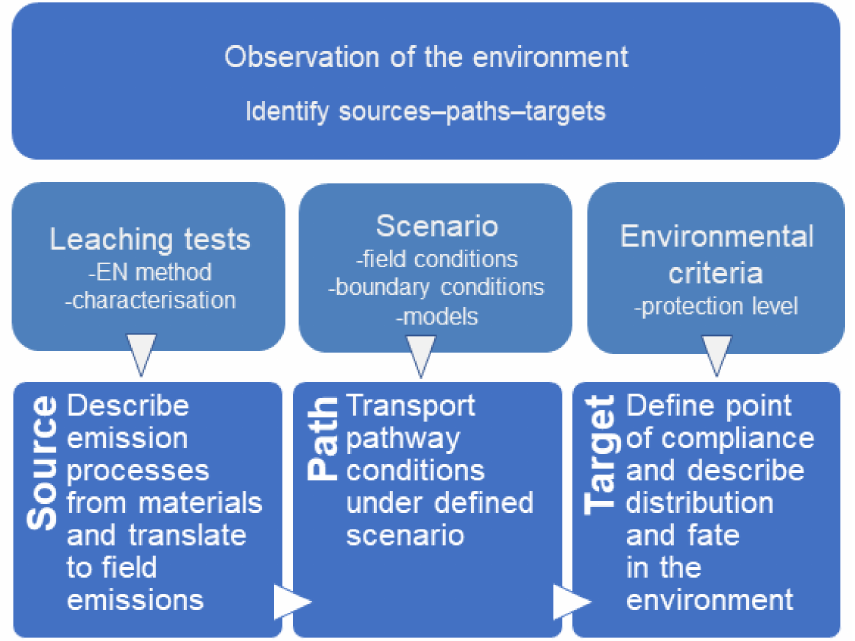
Figure 9. Conceptual framework for environmental impact assessment of (re)-use of construction